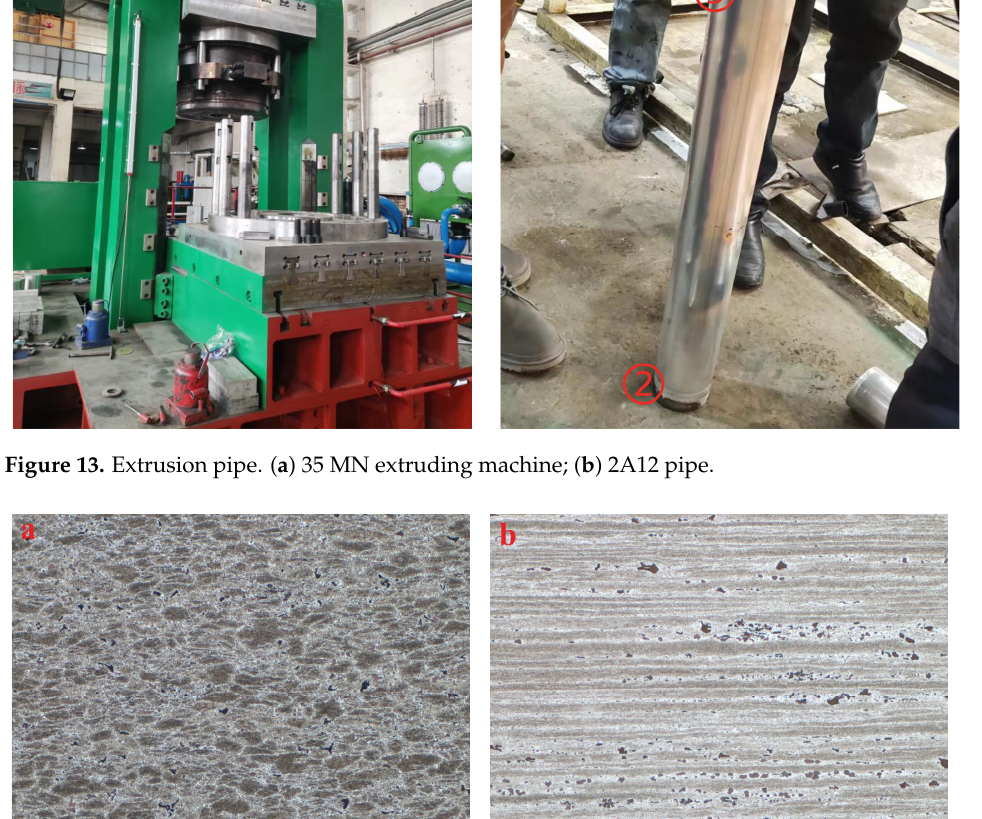
Figure 14. Extruded pipe’s metallographic image ( a ) Along the extrusion direction; ( b ) Vertical extrusion direction.